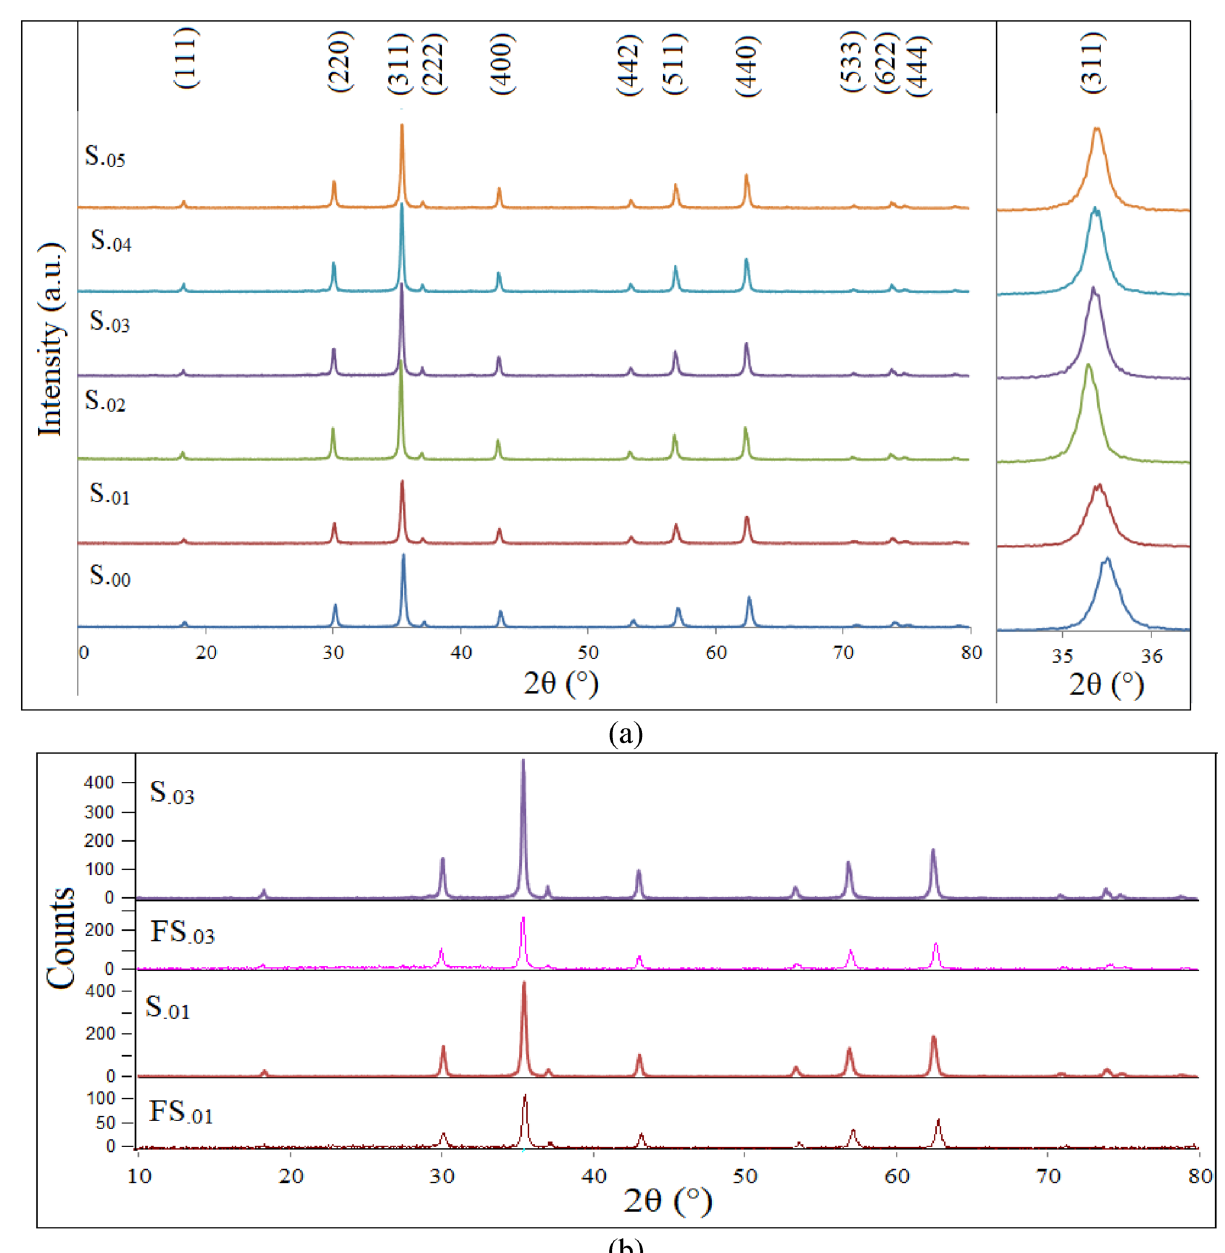
Figure 4. ( a ) XRD patterns of the as-prepared nanoparticles. Inset exhibits (311) diffraction peak to show the displacement of the peaks as Sm 3+ content varies, and ( b ) XRD patterns of selected uncoated and coated